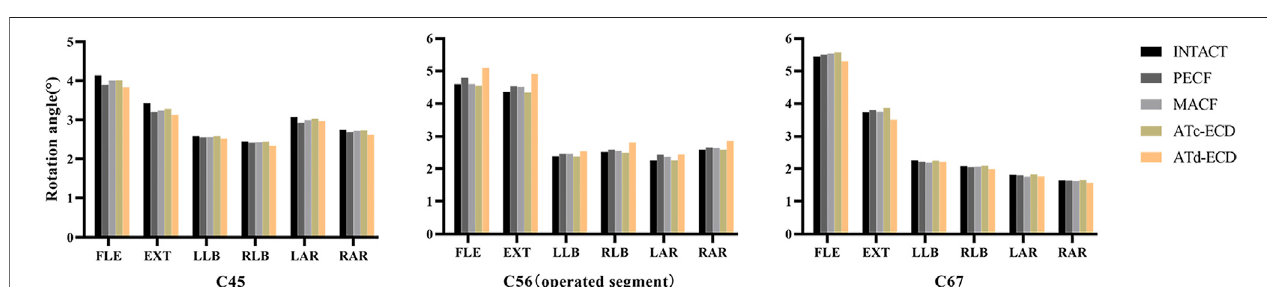
FIGURE 4 | The ROM of C4 – C5, C5 – C6, and C6 – C7 in the intact model and surgical models. FLE, fl exion; EXT, extension; LLB, left lateral bending; RLB, right lateral bending; LAR, left axial rotation; RAR, right axial